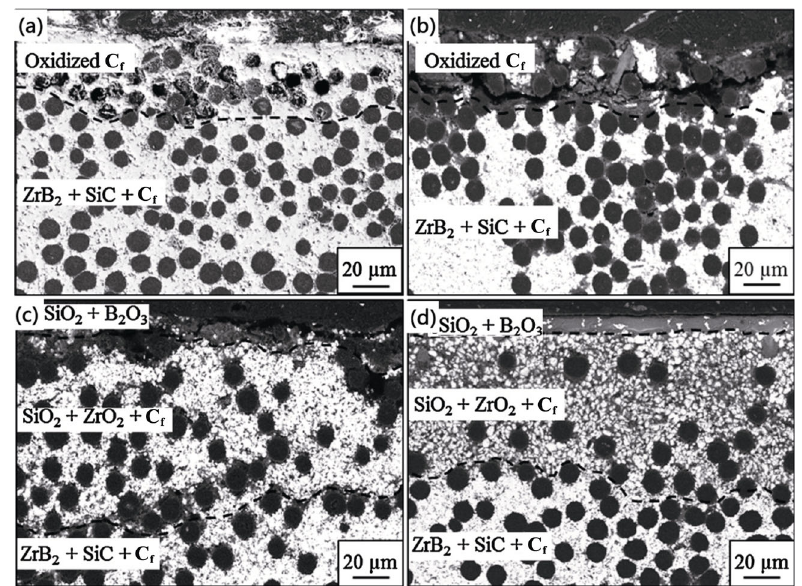
Fig. 24 Cross sections of C f /ZrB 2 –SiC after 6-h oxidation in flowing air at